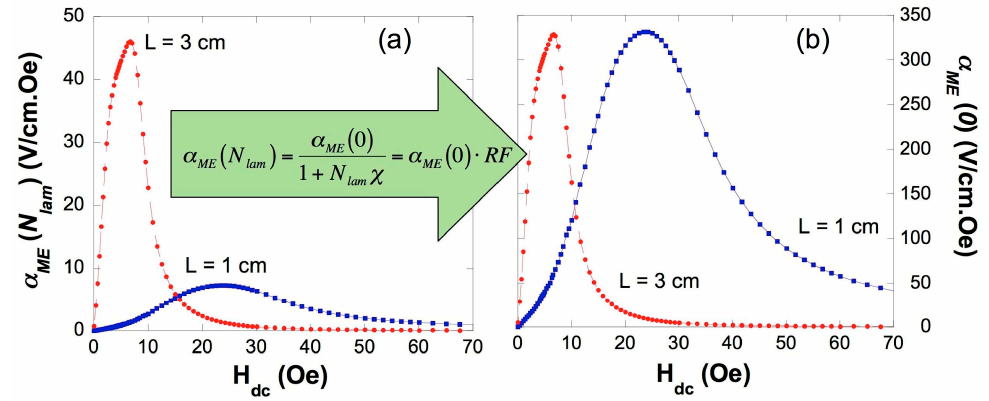
Figure 9. ( a ) Measured or effective ME coefficient of the L = 3 cm and 1 cm length laminates; ( b ) the corresponding intrinsic ones, both represented as a function of the applied magnetic field.